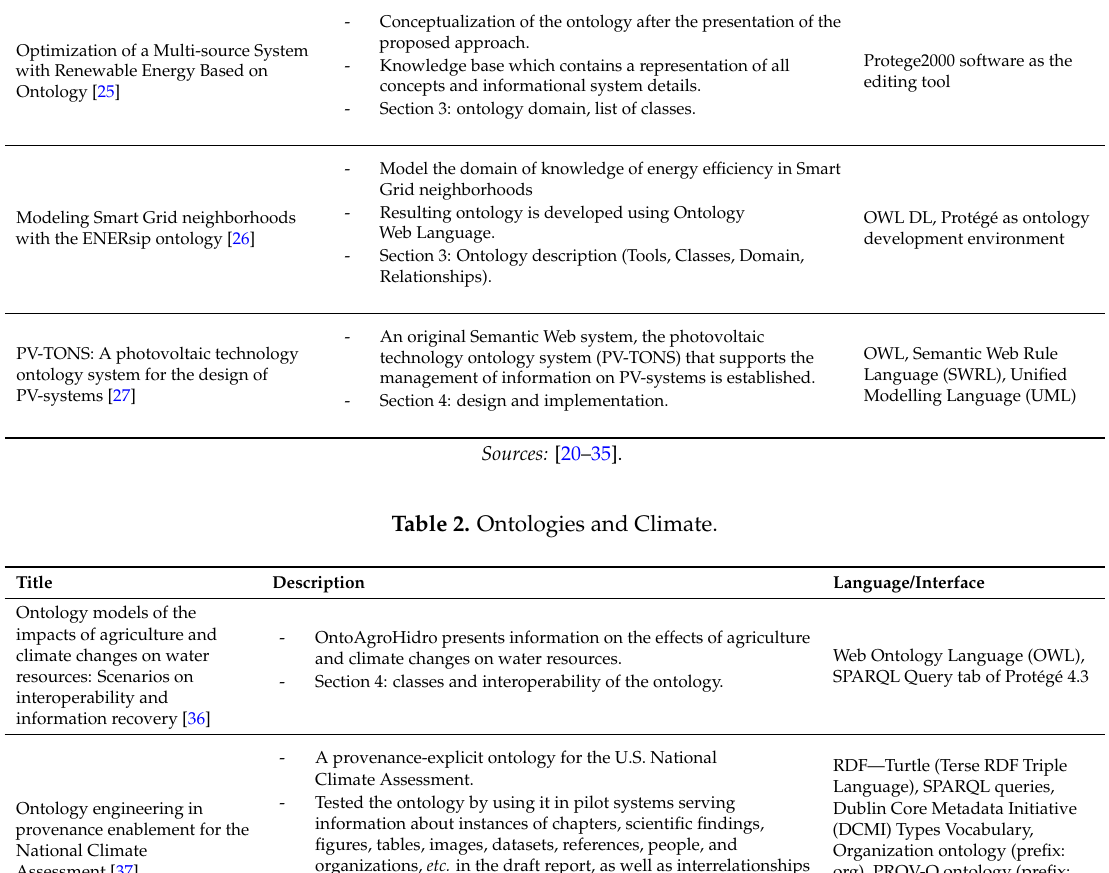
Protege2000 software as the editing tool